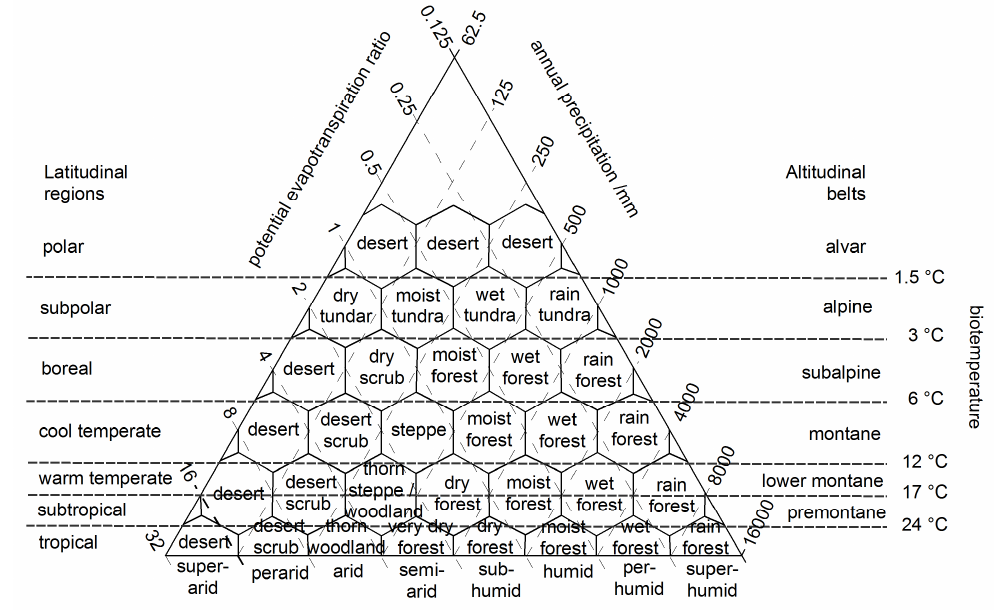
Figure 2. The concept framework of Holdridge Life Zone model, which divides world territorial ecosystems into 39 vegetation zones (life zones)